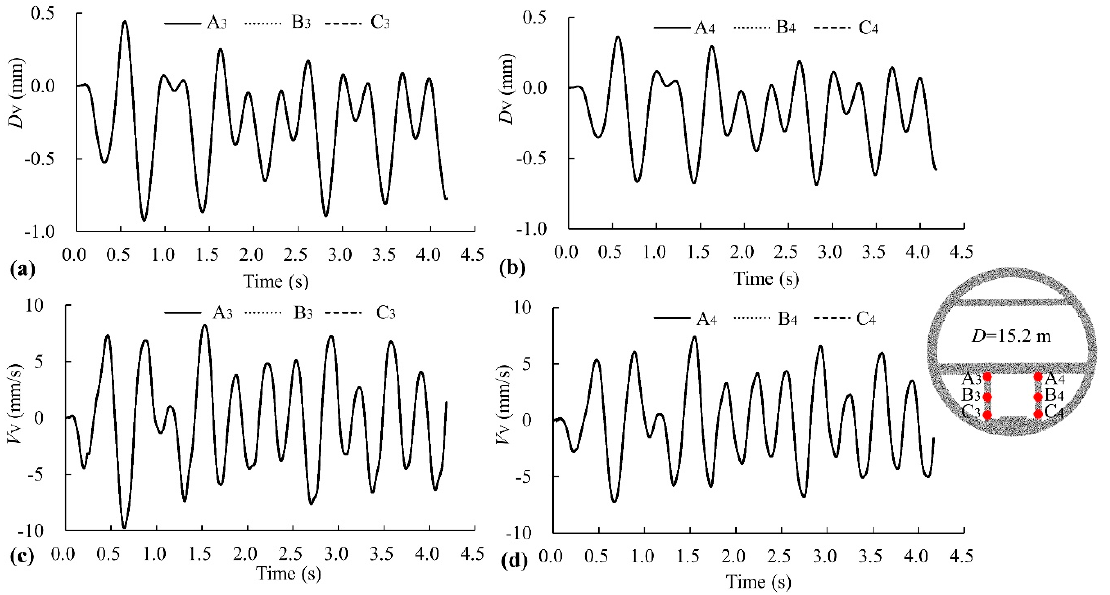
Figure 13. Vertical displacement and velocity of Wall_3 and Wall_4 in T2: ( a ) D V of Wall_3; ( b ) D V of Wall_4; ( c ) V V of Wall_3; and ( d ) V V of Wall_4.